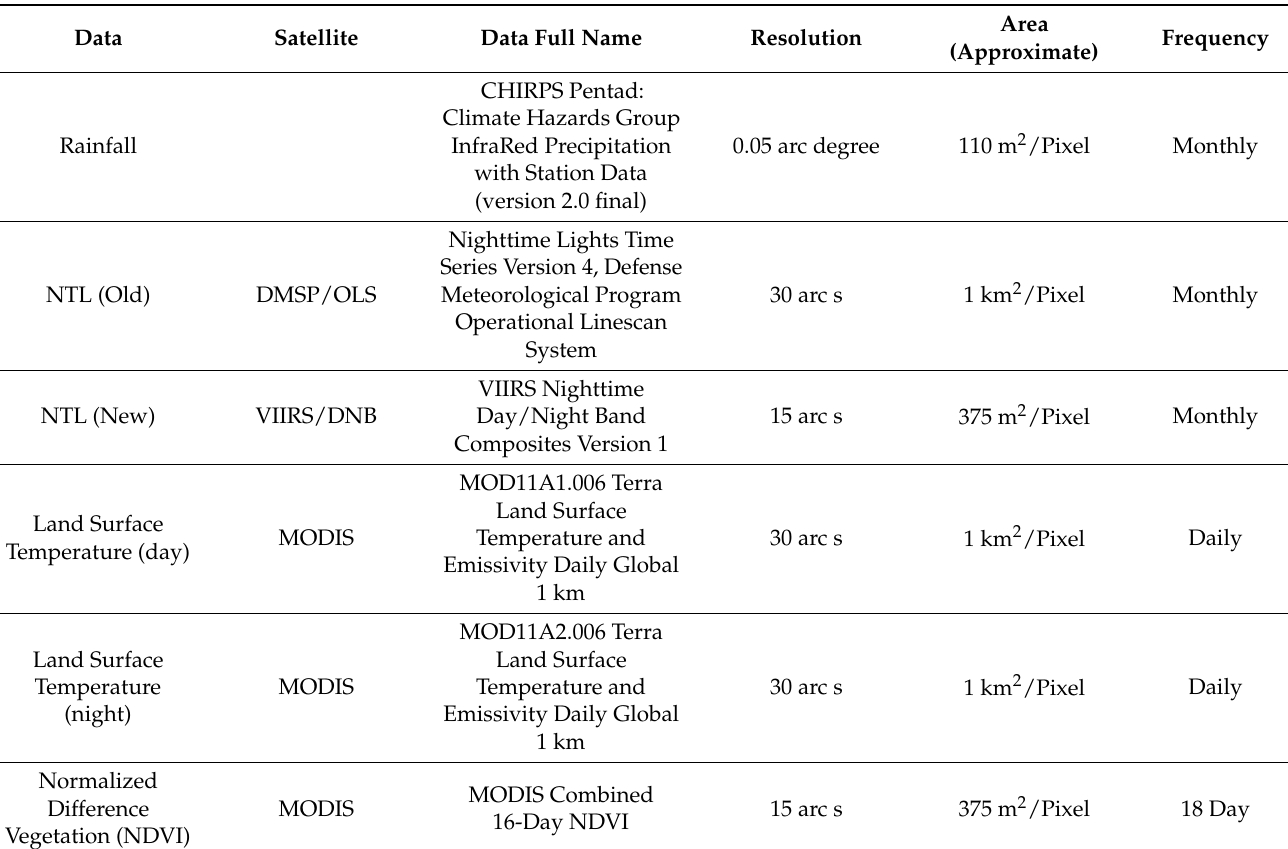
Table 1 summarizes the range of data that can be obtained from Google Earth Engine. Table 1. Technical specification of data obtained from Google Earth